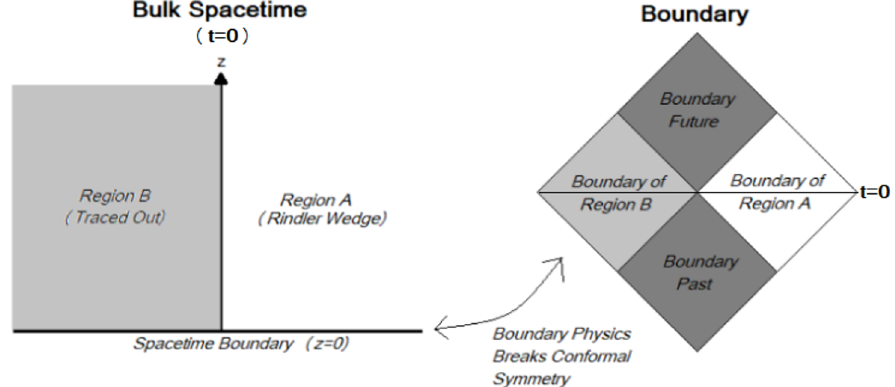
Figure 2 . We consider bulk spacetimes with boundary, either half Minkowski space or Anti-de Sitter spaces. Both have boundaries which are Minkowski space of one lower dimension. Mixed boundary conditions break conformal symmetry of the boundary, where for the latter we are think- ing holographically. We are interested in computing the entanglement entropy of a Rindler wedge whose horizon intersects the z